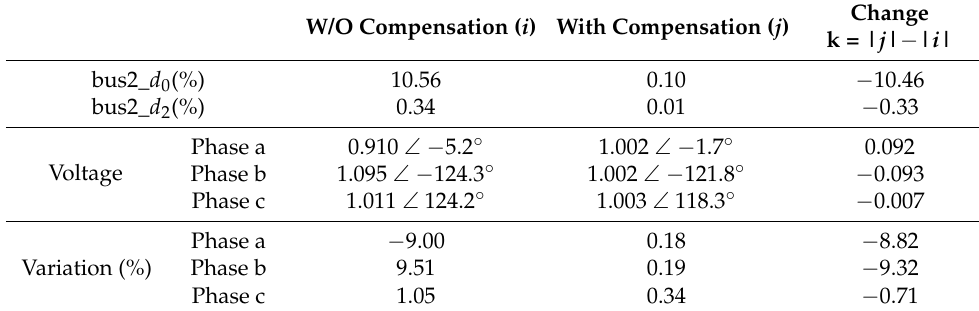
Table 3. Voltage unbalanced factor and voltage variation in Case A.